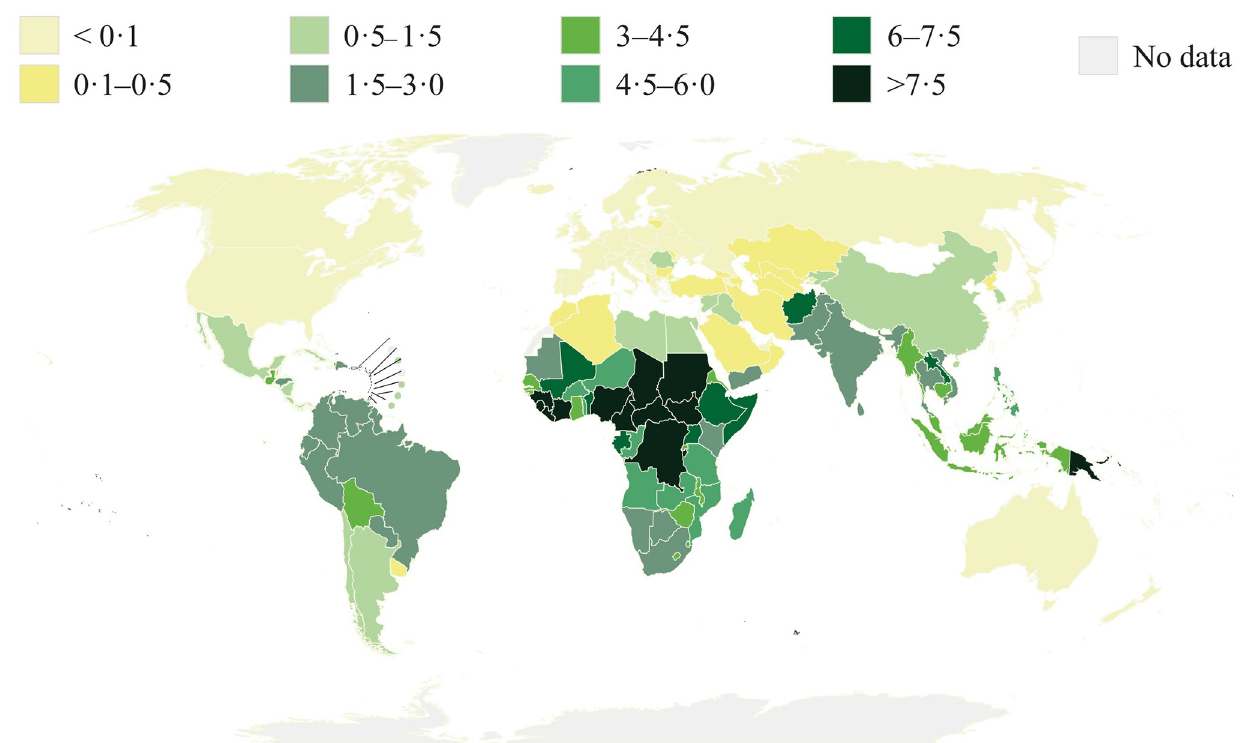
Fig 1. Spread of NTDs. Cumulative DALYs lost of afflicted populations due to the NTDs human African trypanosomiasis, chagas disease, schistosomiasis, leishmaniasis, lymphatic filariasis, onchocerciasis, taeniasis cysticercosis, echinococcosis, dengue, trachoma, rabies, leprosy, and soil-transmitted helminthiases. World map adapted from WHO [8]. DALY, disability-adjusted life year; NTD, neglected tropical disease; WHO, World Health Organization.